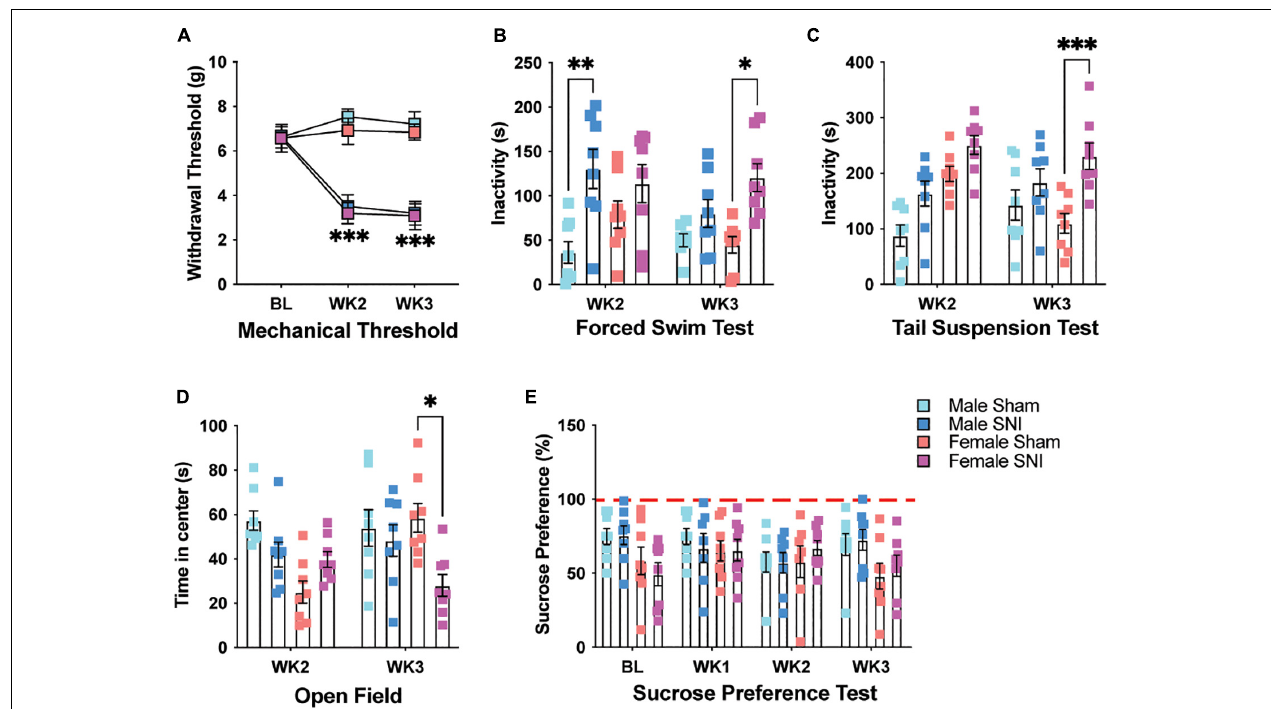
FIGURE 1 | SNI induces mechanical sensitivity and depressive-like behavior. (A) Mechanical allodynia is evident in male and female mice following SNI, but not sham surgery, 2- and 3-week post-injury ( n = 16 for BL and WK2; n = 8 for WK3/sex/condition). (B) SNI increases immobility on the forced swim test in male mice 2-week post-surgery, while immobility increases in female SNI mice 3-week post-surgery ( n = 8/sex/condition). (C) SNI increases immobility on the tail suspension test in female mice 3-week post-surgery ( n = 8/sex/condition). (D) Female SNI mice spend less time in the center area of the open field 3-week post-surgery ( n = 8/sex/condition). (E) SNI did not alter sucrose preference in male and female mice at any of the tested timepoints ( n = 7–8/sex/condition). ∗ p < 0.05; ∗∗ p < 0.001; ∗∗∗ p <